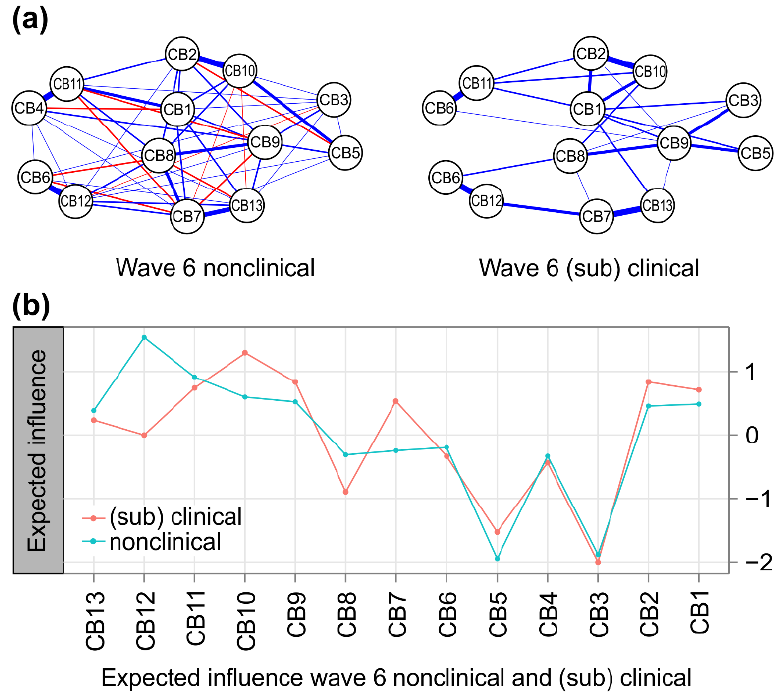
Figure 3. ( a ) A comparison of 13 nodes’ CBCL behavioral problems in nonclinical ( left ) and (sub)clinical ( right ) groups. The blue lines represent positive associations, and the red lines indicate negative ones. The width and brightness of the edge indicate the strength of the association. The maximum edge in the nonclinical group was 0.77 (CB6 = attention problems; CB12 = DSM attention-deficit/hyper-activity problems), and the maximum edge in the (sub)clinical group was 0.64 (CB7 = aggressive behaviors; CB13 = DSM oppositional defiant problems), but the maximum edge was unified as 0.55 for comparison. ( b ) Nonclinical (total problem behavior T-score < 60, blue) versus (sub)clinical (total problem behavior T-score ≥ 60, orange) individual node strength values are shown as standardized z -scores. CB1 = emotionally reactive; CB2 = anxious/depressed; CB3 = somatic complaints; CB4 = withdrawn; CB5 = sleep problems; CB6 = attention problems; CB7 = aggressive behaviors; CB8 = other problems; CB9 = DSM affective problems; CB10 = DSM anxiety problems; CB11 = DSM pervasive developmental problems; CB12 = DSM attention-deficit/hyper-activity prob- lems and CB13 = DSM oppositional defiant